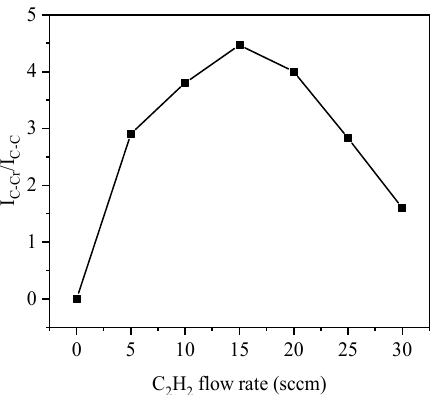
Figure 4. The atomic ratio of carbide to carbon in CrC coatings deposited at different C 2 H 2 flow rates, carbide is C in CrC, carbon is C in a-C:H.